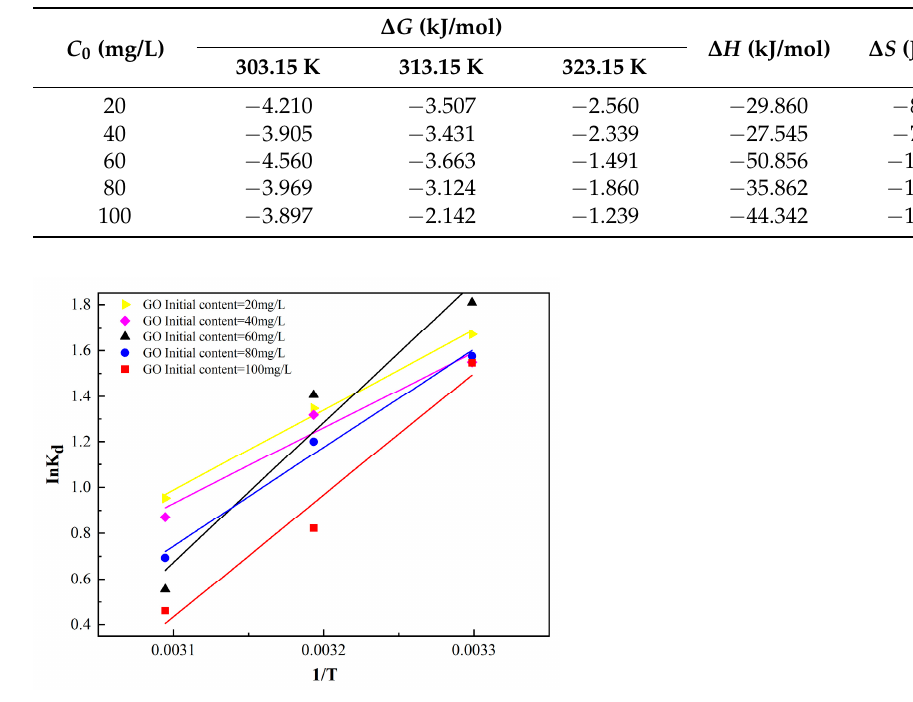
Table 2. Parameters of thermodynamic equation.